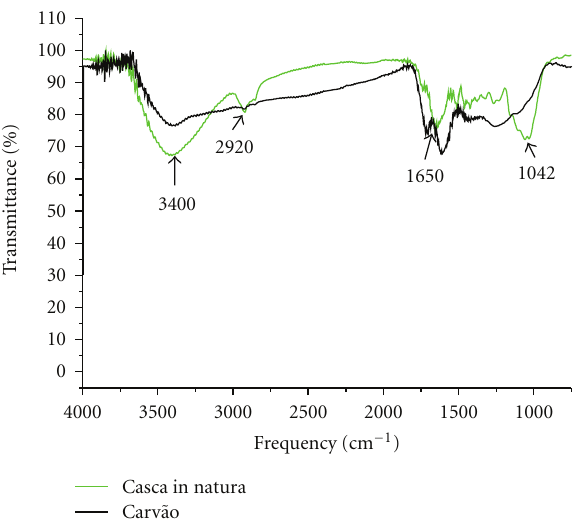
Figure 2: FT-IR spectra for Moringa oleifera husks and activated